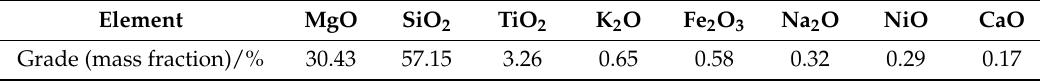
Table 1. Chemical analysis results of talc